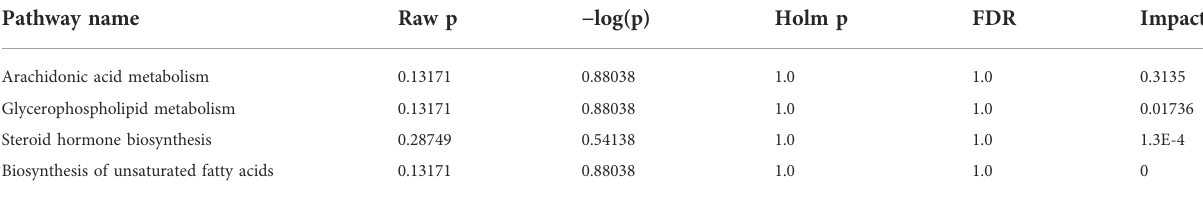
TABLE 3 Analysis parameters of metabolic